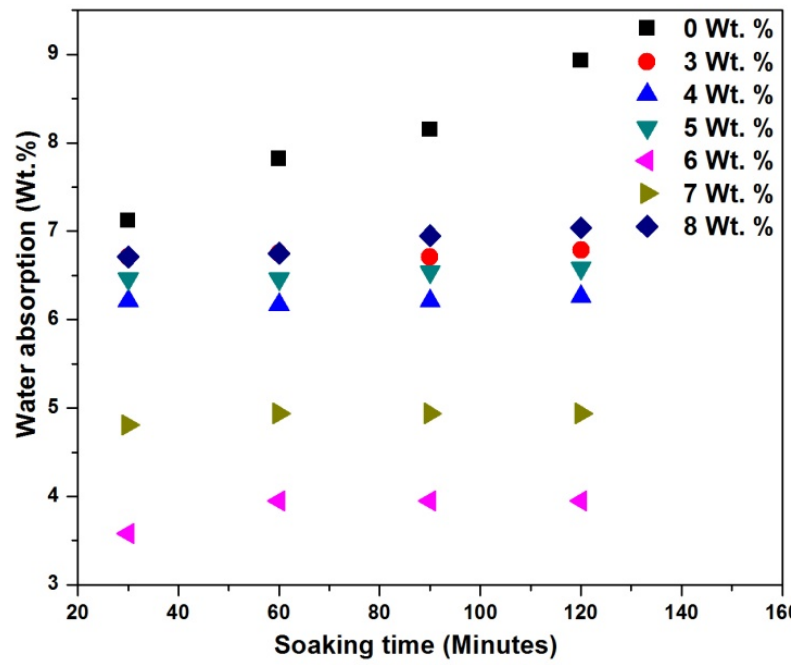
Figure 9. Water absorption of treated CCP-PLA nanofibre at 70 °C.